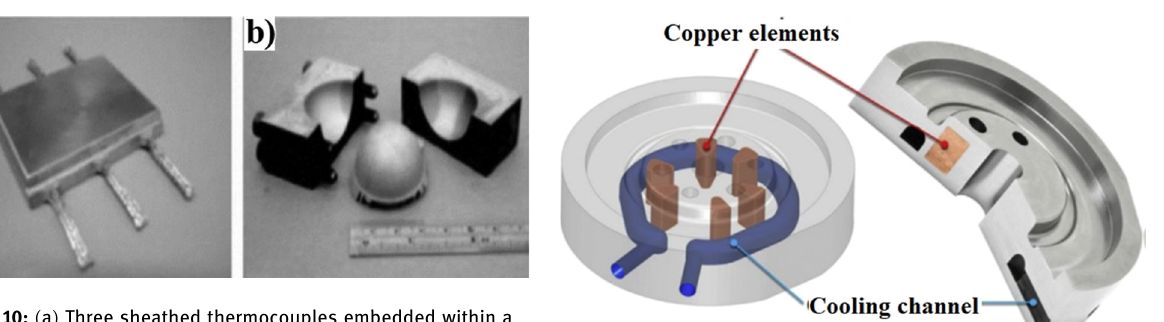
Figure 10: ( a ) Three sheathed thermocouples embedded within a titanium part and ( b ) titanium hemisphere formed by mould tool [ 55 ] .